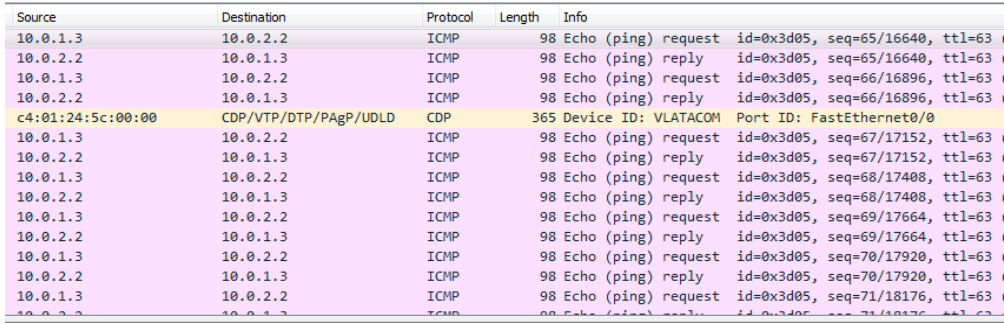
Figure 7. Eavesdropping detection with Wireshark (unencrypted traffic example).